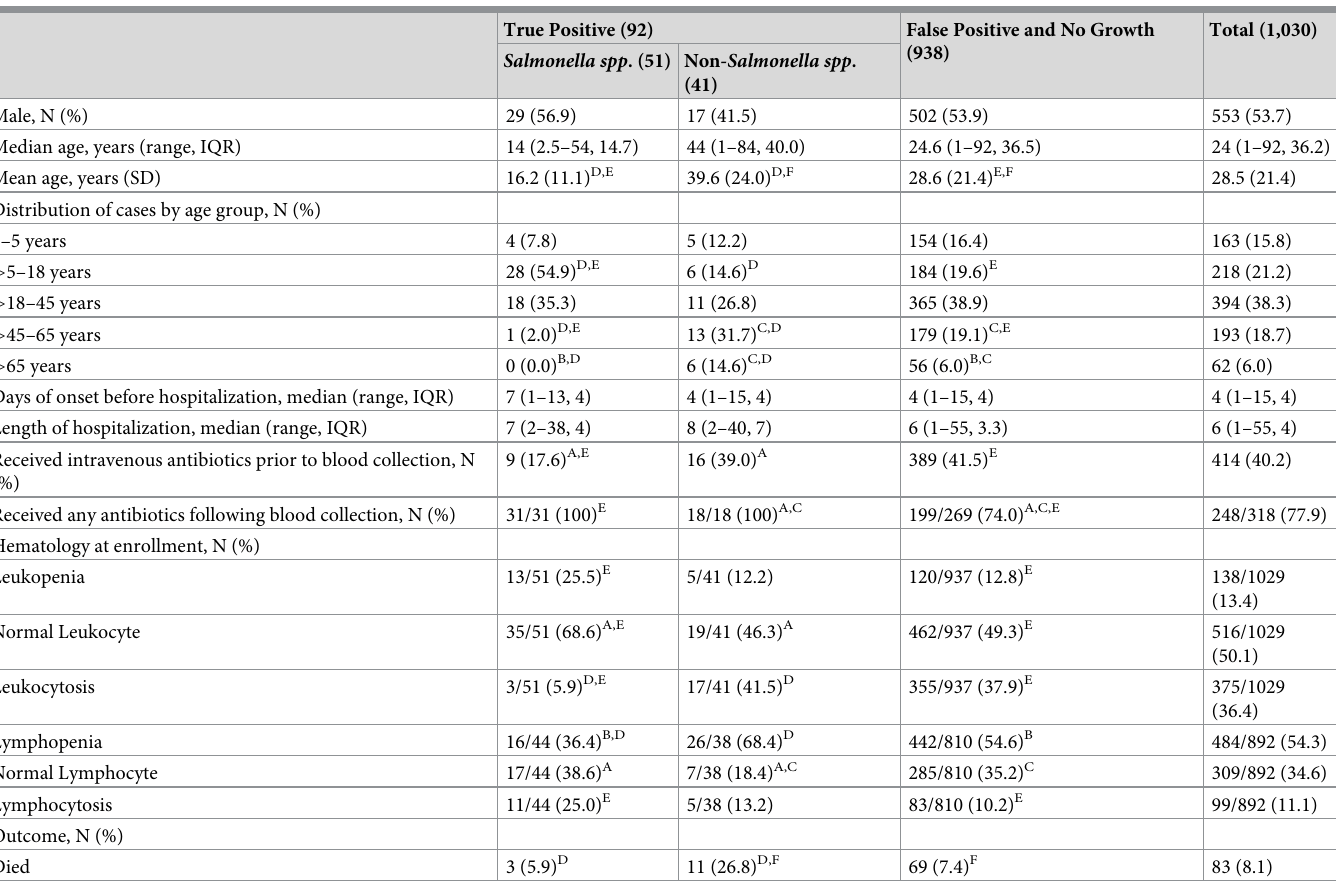
Table 2. Participant characteristics, hematology results, and mortality.